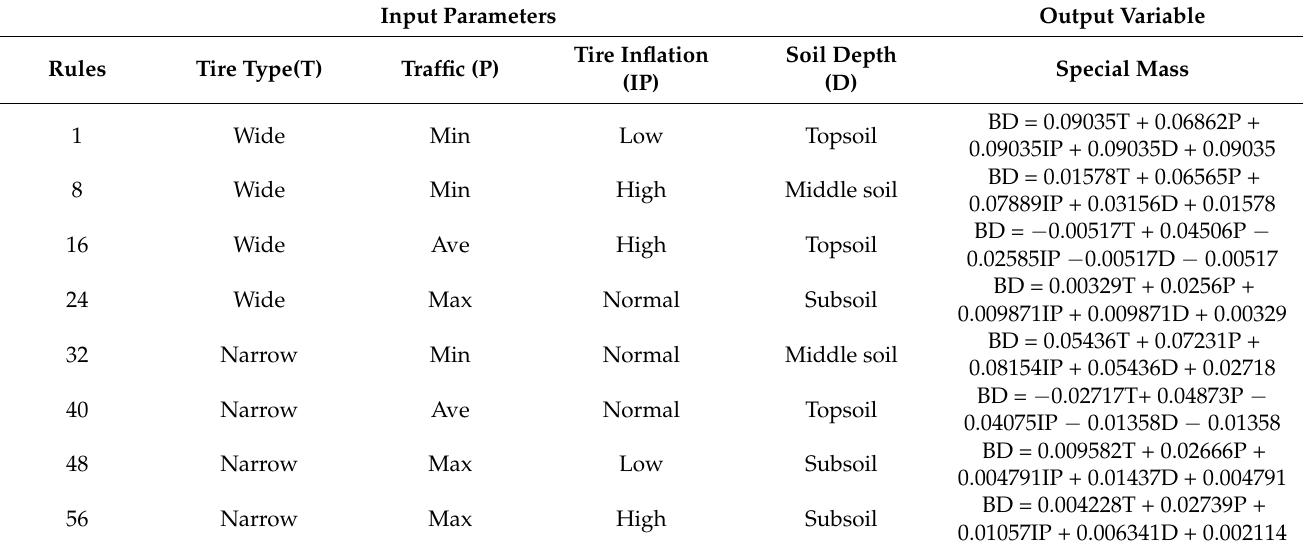
Table 2. Some rules created in the ANFIS